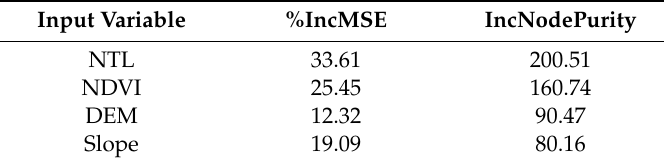
Table 2. The importance of input variables for random-forest (RF) model of population